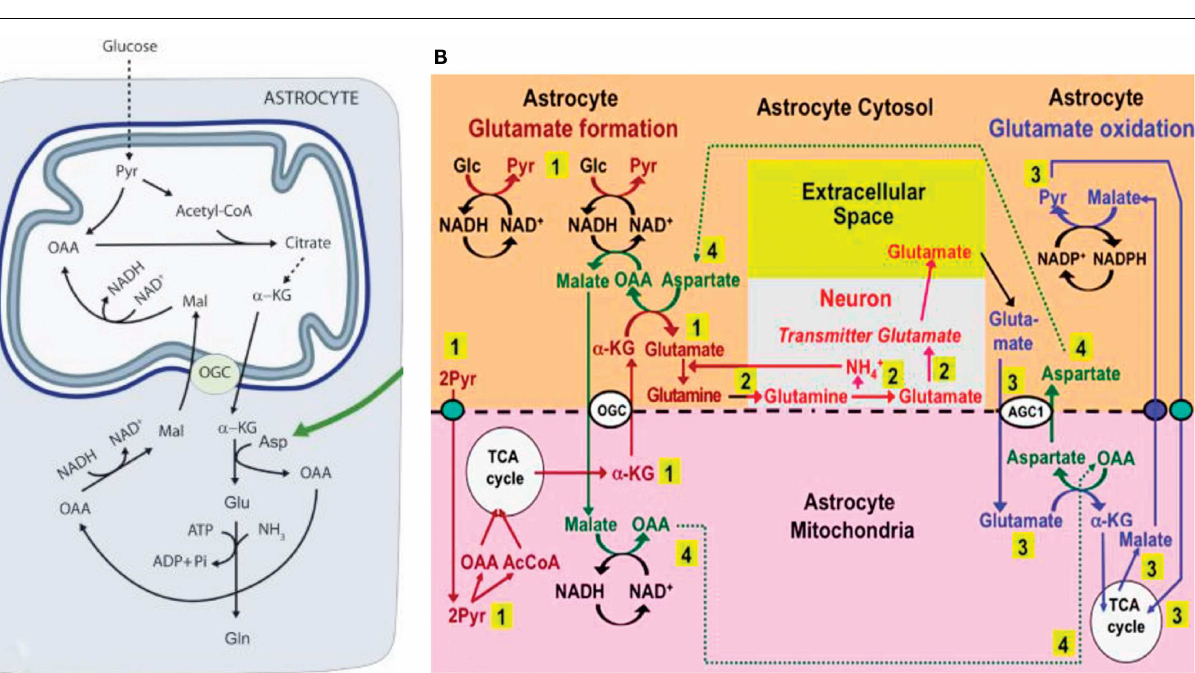
FIGURE 3 | (A) Cartoon describing metabolic pathway from pyruvate to glutamate/glutamine in astrocytes, as suggested by Pardo et al. (2011). Joint pyruvate carboxylase and pyruvate dehydrogenase activation generates a “new” molecule of citrate as described above. Citrate-derived α -ketoglutarate exiting the mitochondrial membrane leaves the astrocytic TCA cycle and is transaminated with aspartate to form glutamate, with concomitant oxaloacetate (OAA) formation from aspartate.The mitochondrial exit of α -ketoglutarate occurs via the ketoglutarate/malate exchanger, generally acknowledged to be expressed in astrocytes, and the cytosolic malate with which is exchanged, is generated via NADH-supported reduction of aspartate-generated oxaloacetate. No aralar-requiring aspartate/glutamate exchanger (Slc1) activity is involved. (B) Proposed expansion by Hertz (2011a) of the model shown in (A) .The expanded model shows astrocytic production of glutamine (pathway 1), its transfer to glutamatergic neurons (without indication of any extracellular space, because there is no other function for extracellular glutamine than astrocyte-to-neuron transfer) and extracellular release as the transmitter